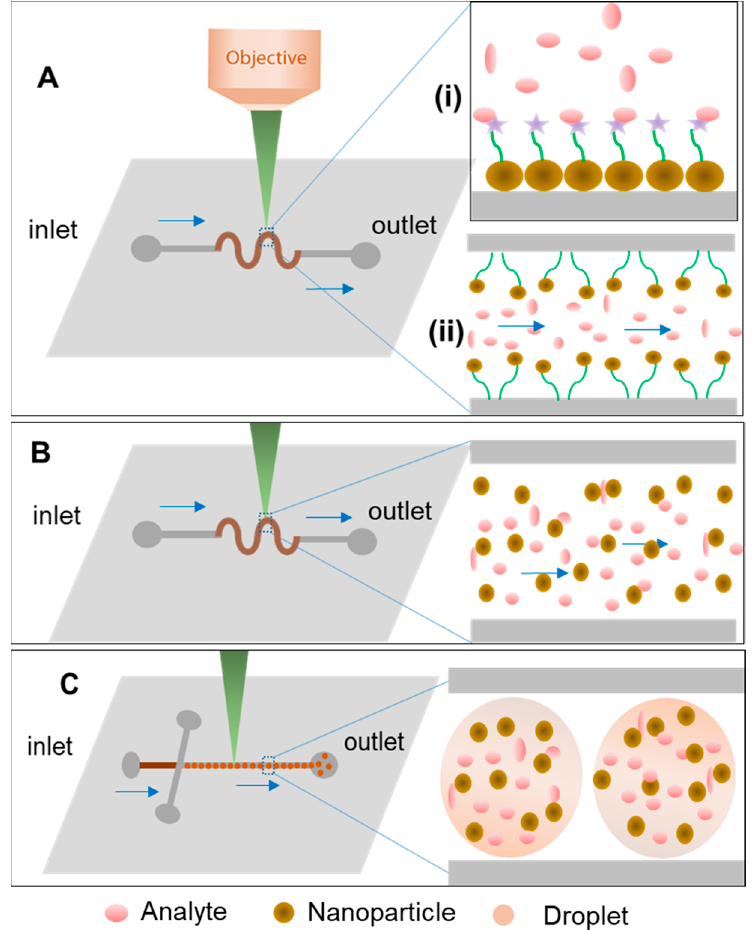
Figure 2. Schematic illustration of different strategies for lab-on-a-chip (LOC)-SERS devices; ( A ) immobilization of NPs in microfluidic channels in (i) static or (ii) continuous flow approach; ( B ) colloidal dispersions and continuous flow approach; and ( C ) in segmented flow.